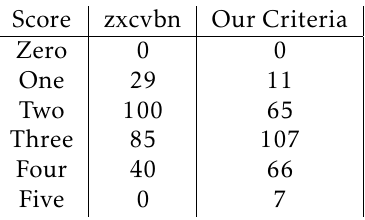
in part 2 of the survey, 70 received a mismatching message and 62 received a matching message.